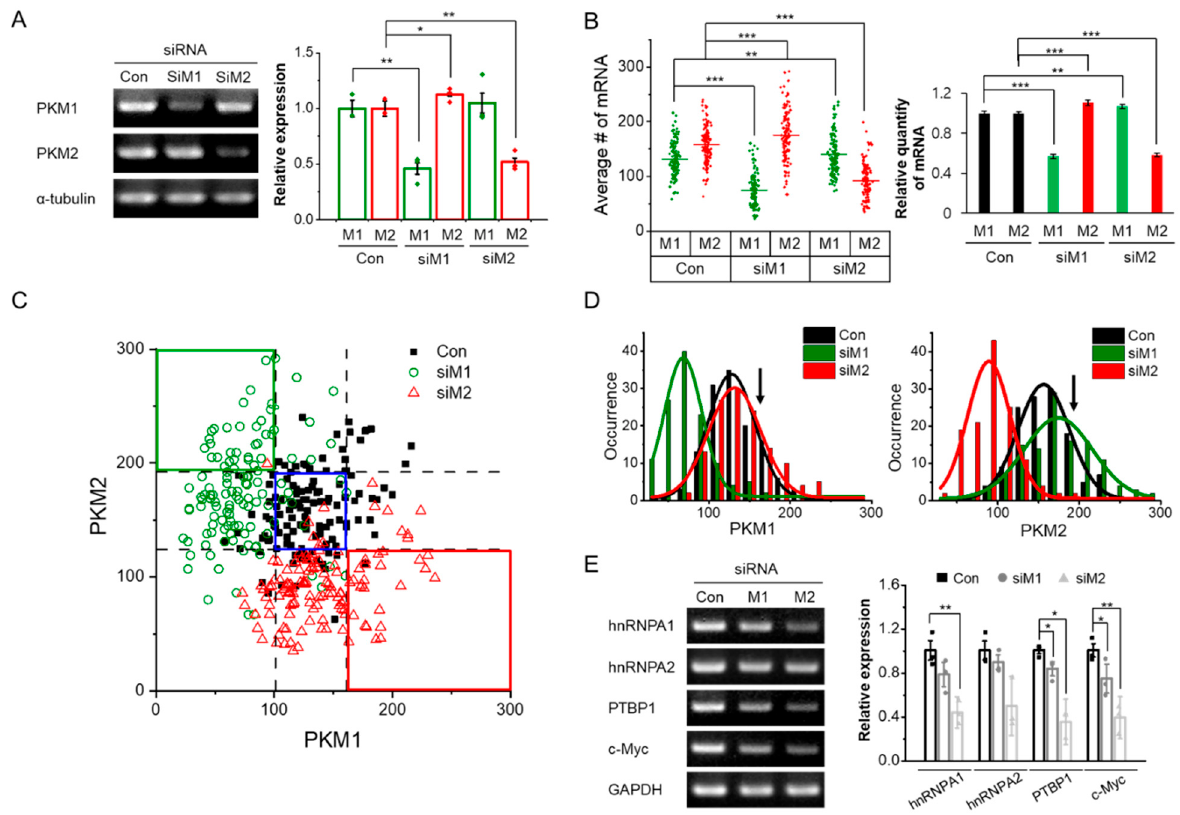
Figure 2. Effects of isoform-specific knockdown on PKM mRNA expression. Cells were treated with a scrambled siRNA (Con), PKM1-specific siRNA (SiM1), or PKM2-specific siRNA (siM2). ( A ) RT- PCR analysis of PKM isoforms. M1 and M2 corresponds to PKM1 and PKM2, respectively. Error bars represent average ± SD ( n = 3) ( B ) Quantitative SM-FISH-STIC analysis of PKM isoforms. The number of mRNA molecules of each PKM isoform in individual cell was counted, and the average value is presented. M1 and M2 corresponds to PKM1 and PKM2, respectively. Error bars represent average ± standard error of the mean (SEM) ( n ≥ 122) ( C ) 2D plot of each PKM isoform in HCT116 cells. Each point corresponds to the number of PKM isoforms in individual cell. The region enclosed within the dotted lines (the average ± SD in control cells) is highlighted in blue. The green box represents cells with a high expression level of PKM2 when PKM1 was depleted (greater than the average value + SD in control cells), and the red box represents cells with a high expression level of PKM1 when PKM2 was depleted (greater than the average value + SD in control cells). ( D ) Distribution of PKM1 ( left ) and PKM2 mRNA ( right ) from individual cells. The black, dark green, and red lines represent the Gaussian fits of each distribution. The black arrows indicate the corresponding average value + SD of the control. ( E ) Determination of relative mRNA levels of regulatory proteins involved in PKM splicing determined by RT-PCR. Data are shown as average ± SD of three independent experiments.* p < 0.05, ** p < 0.01, and *** p <